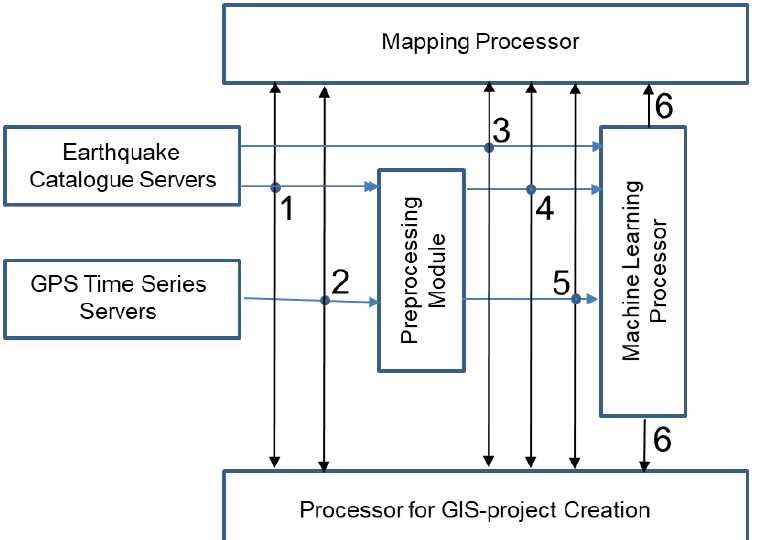
Figure 1. Scheme of the process of data analysis in GIS Prognosis: 1. Catalog of earthquakes. 2. GPS time series. 3. Catalog of target earthquakes. 4. Seismological spatiotemporal grid fields. 5. Geodynamic spatiotemporal grid fields. 6. Spatiotemporal grid field of